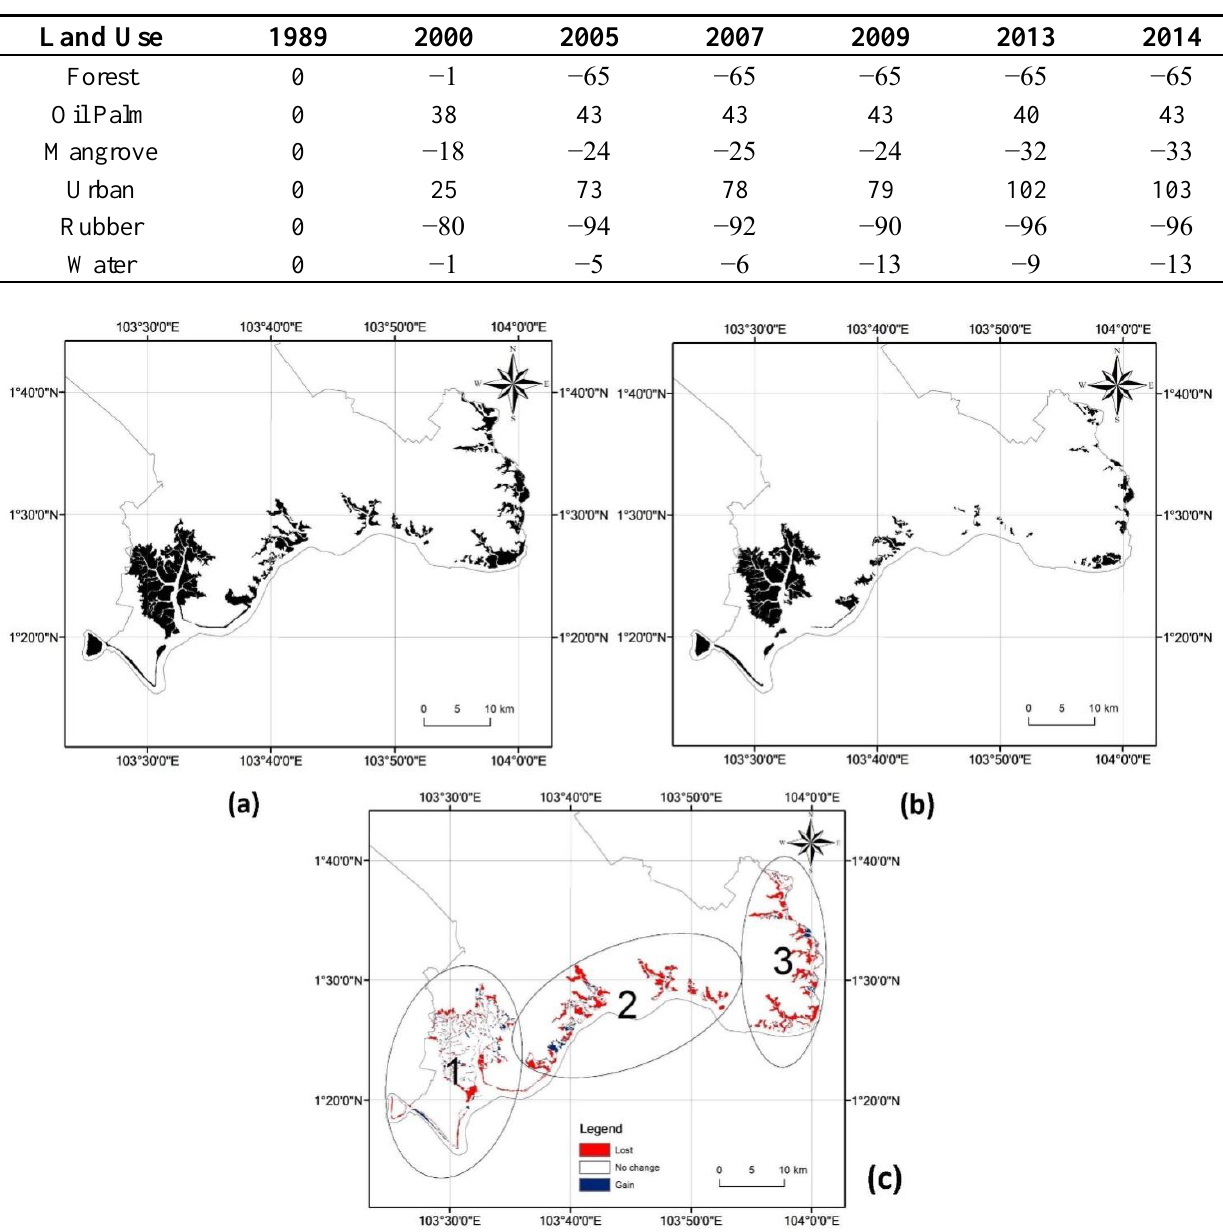
Table 4. The percentage (%) change in area by comparing the land use in 2000, 2005, 2007, 2009, 2013 and 2014 with 1989 as a base year. The negative sign shows the % loss in the area compared to 1989 while the positive shows the % gain in the area compared to 1989.